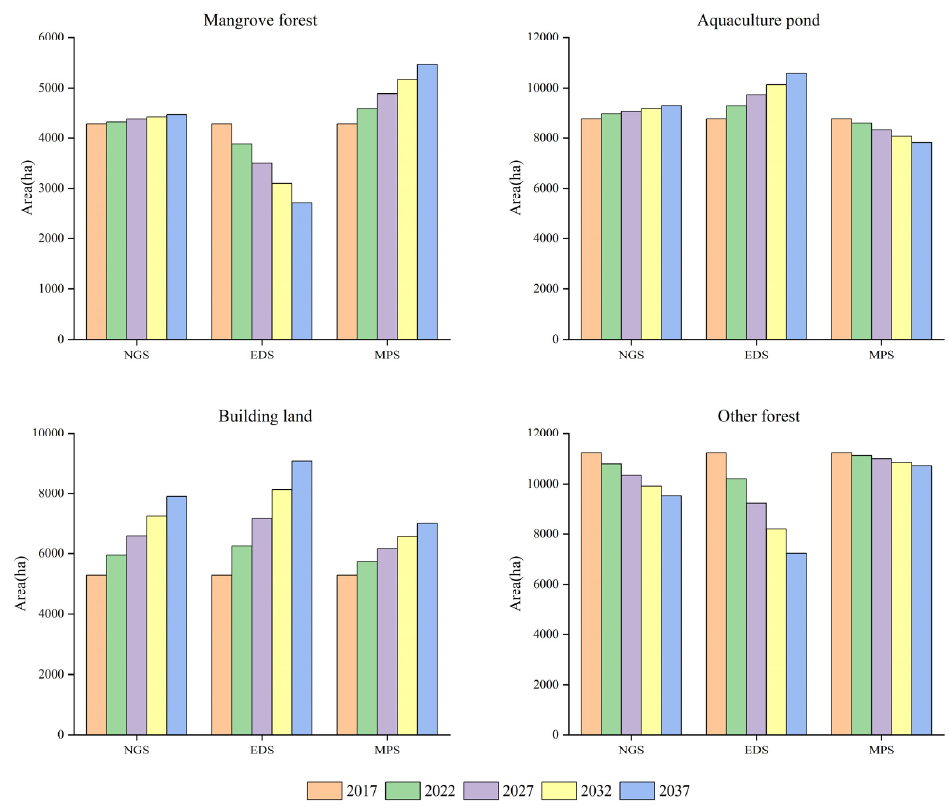
Figure 6. Area changes of mangrove forests and three related land cover types (aquaculture ponds, building land and other forests) from 2017 to 2037.